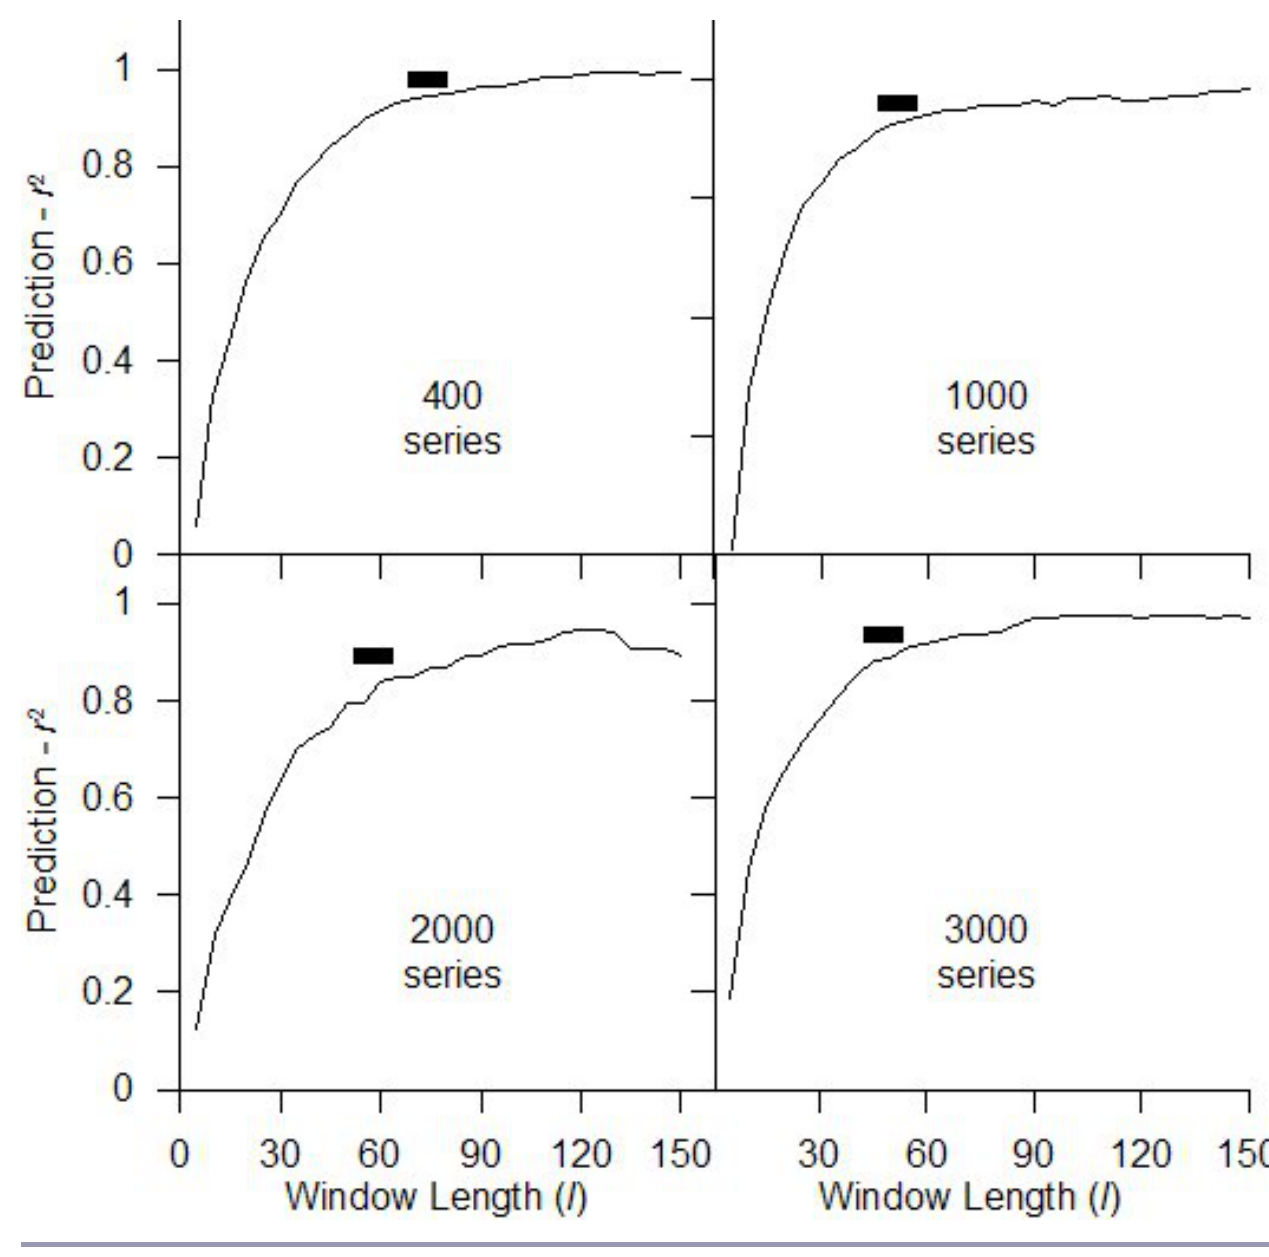
Fig. 3. The effect of changing community dynamics on the CLS of the five-species system shown in Fig. 2A. Prediction-r 2 spectra (based on analysis of densities of S ) were produced from series of five maps 5 of the landscape commencing at generation 400 (before environmental change inducing a reduction in the growth rate of S at generation = 500) and, after the reduction in growth rate, commencing at 5 generations 1000, 2000, and 3000. Consecutive maps in each series were separated by 10 time steps. The change in dynamics is reflected by a reduction in the CLS from about 75 to 50 length units. Areas identifying the CLS are shown as black horizontal